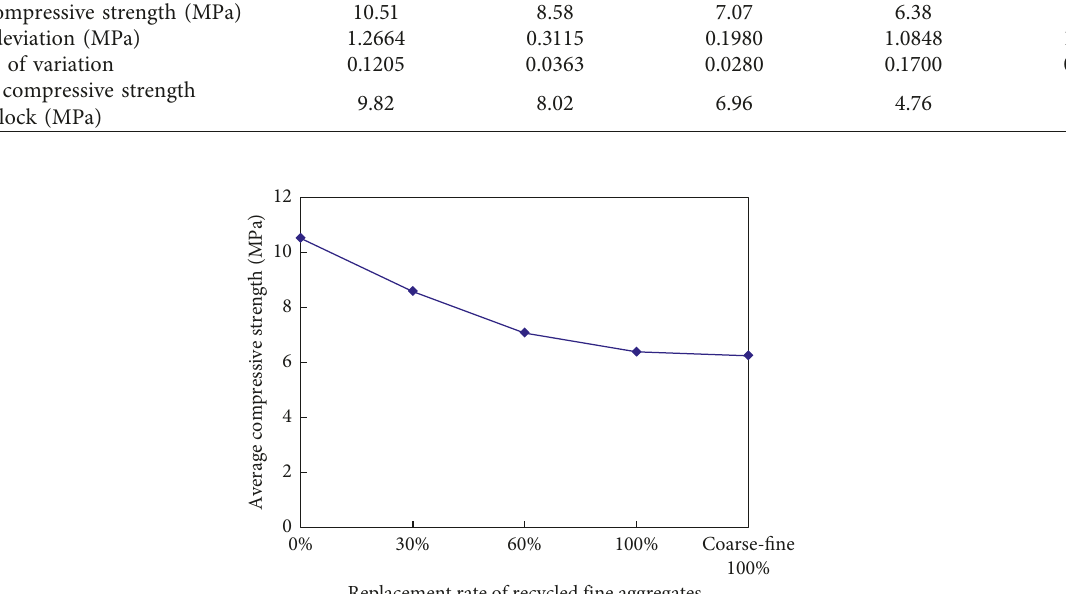
Table 7: Summary of the test results of compressive strength of recycled blocks with different substitution rates of MU10. Block RCB-10-1